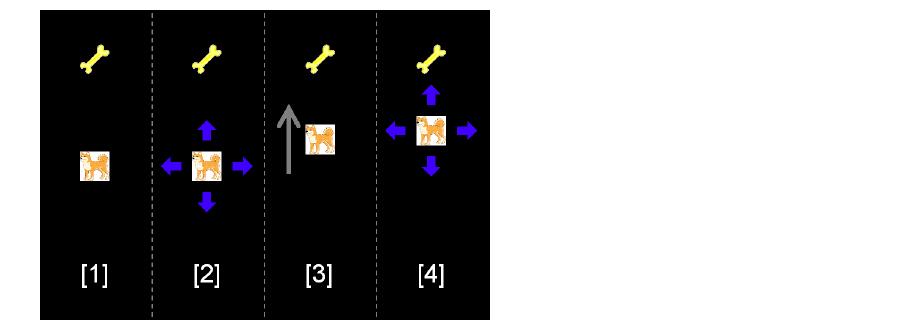
Fig. 1. Illustration of the navigation task used in order to solve the TSPs. The white square having a picture of a dog represents the target, and the picture of a bone at the top represents the goal. The gray arrow depicted in [3] represents the target’s movement. See the Procedure section for description of each stage of navigation